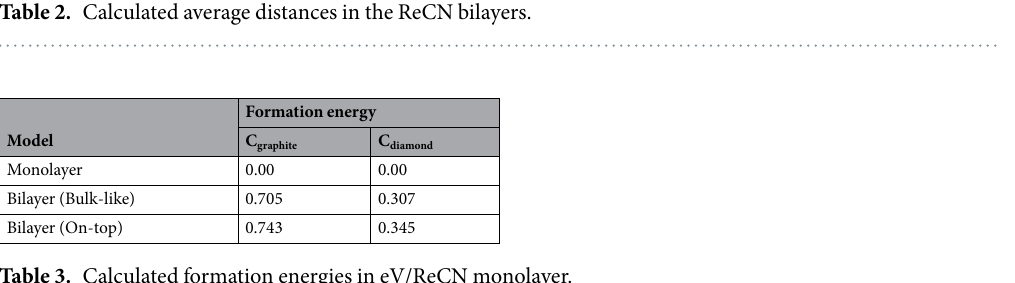
Table 3. Calculated formation energies in eV/ReCN